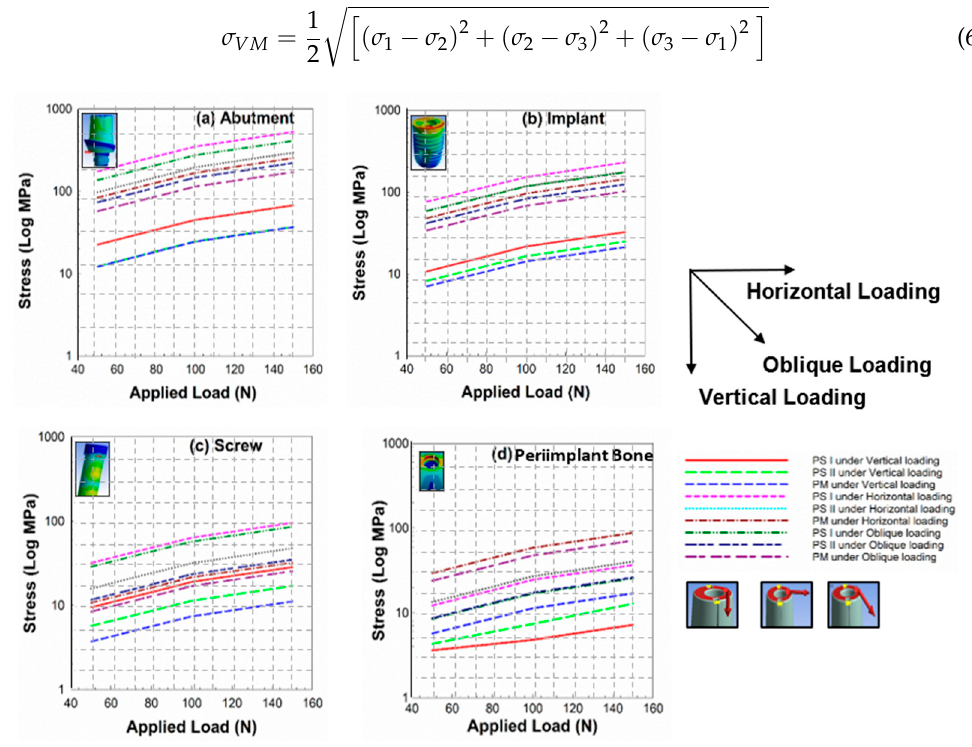
Figure 6. Graphs representing stress analysis of ( a ) abutment, ( b ) implant, ( c ) screw, and ( d ) peri- implant bone for PS I, PS II, and PM configuration under different loading conditions.